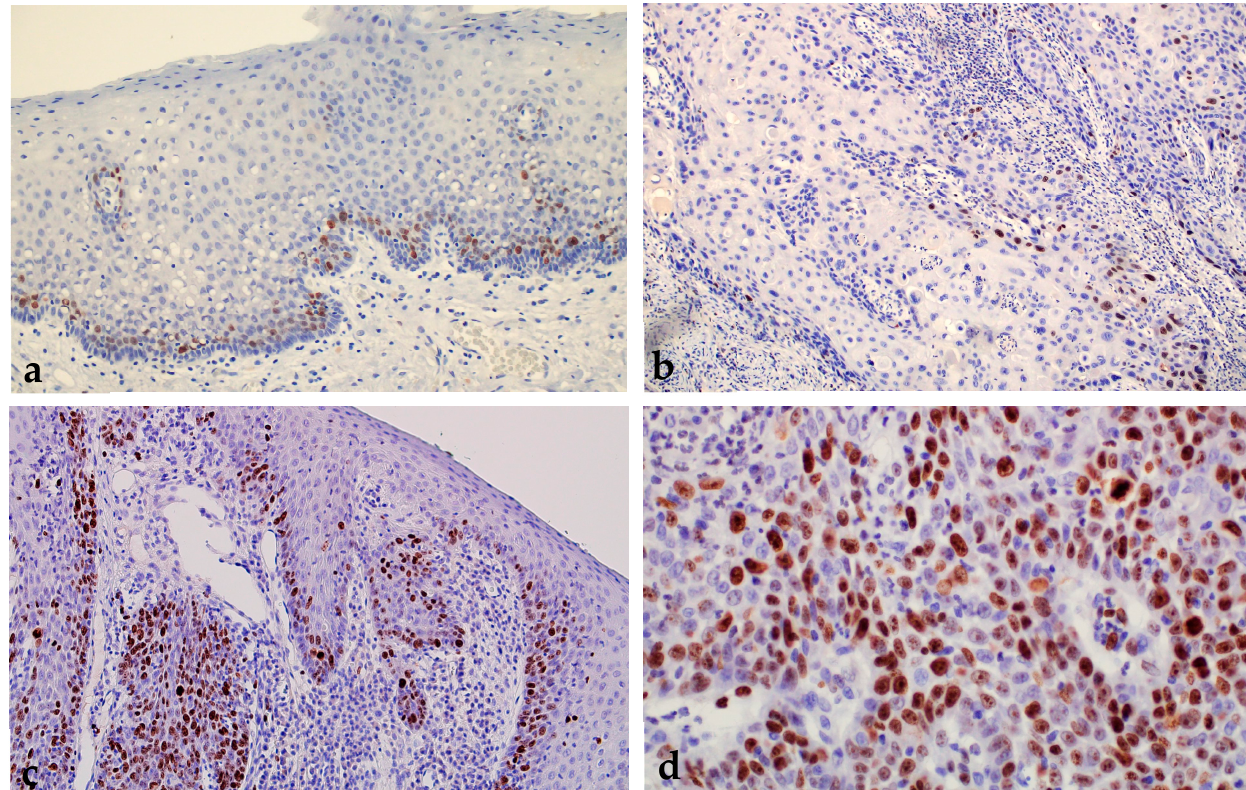
Figure 2. Oral erythroplakia with weak expression of Ki-67. Magnification 200 × ( a ). OSCC showing a very low proliferation index. Magnification 100 × ( b ). Immunohistochemical expression of Ki-67 in oral leukoplakia with moderate proliferation activity. Magnification 100 × ( c ). OSCC with high proliferation activity with expression of Ki-67 in more than 30% of nuclei. Magnification 400 × ( d